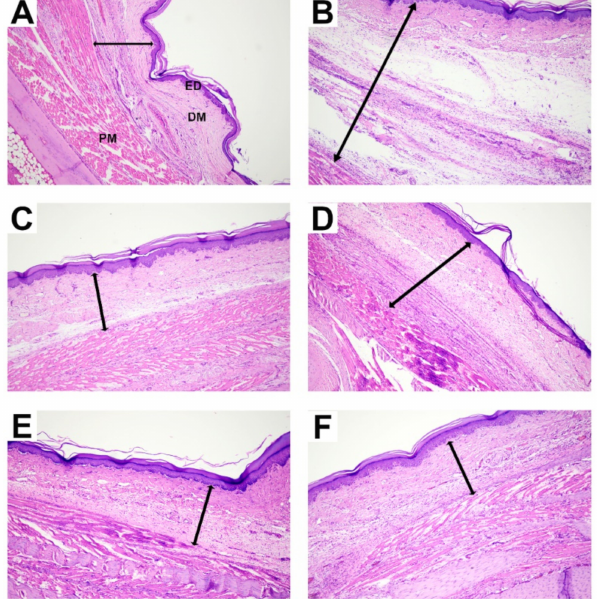
Figure 4. Histopathological examination of paw tissue of rats, pretreated with vehicle (0.9% saline), ibuprofen (100 mg/kg), or ZO essential oil at different doses, at 6 h after carrageenan injection. The tissue section from the paw tissue of each rat was stained with hematoxylin and eosin (100 × ). ( A ) Normal control group (no carrageenan injection); ( B ) control group; ( C ) ibuprofen group; ( D – F ) 200, 400, and 800 mg/kg of ZO essential oil groups. The arrow indicates the total thickness. Abbreviations: ED, epidermis; DM, dermis; PM; paw